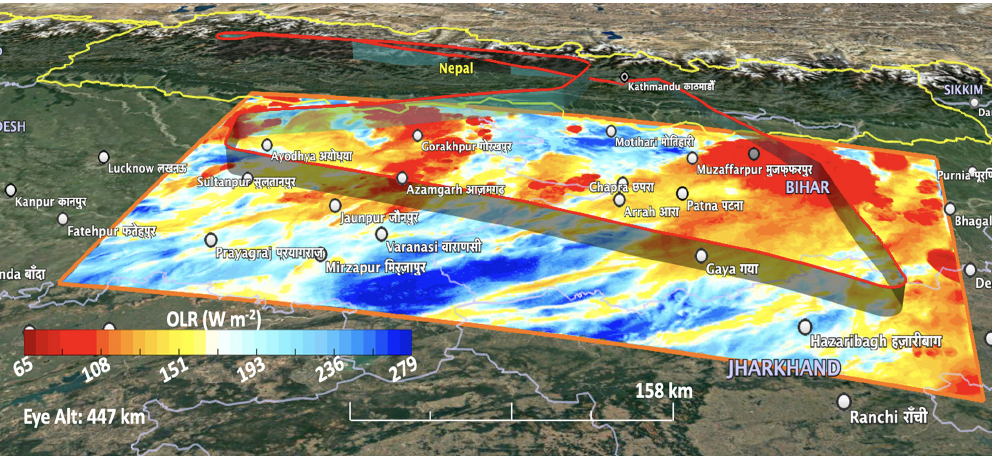
Figure 5. High-resolution (0.3km) simulated OLR at 10:00UTC on 10 August 2017. The map was made using © Google Earth 2022.